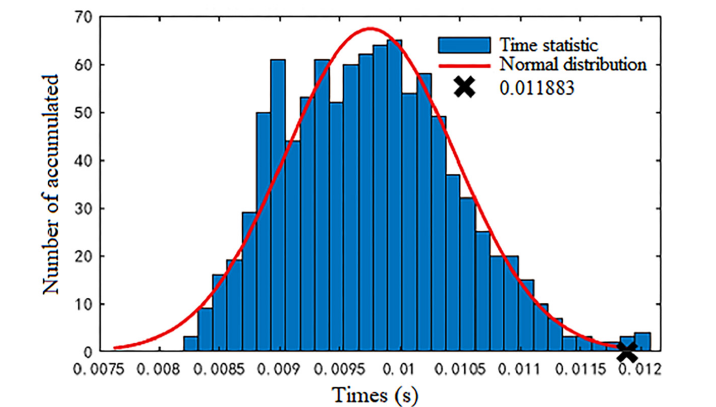
Figure 12. The simulation time statistics of 1000 repeated experiments and their normal distribution.